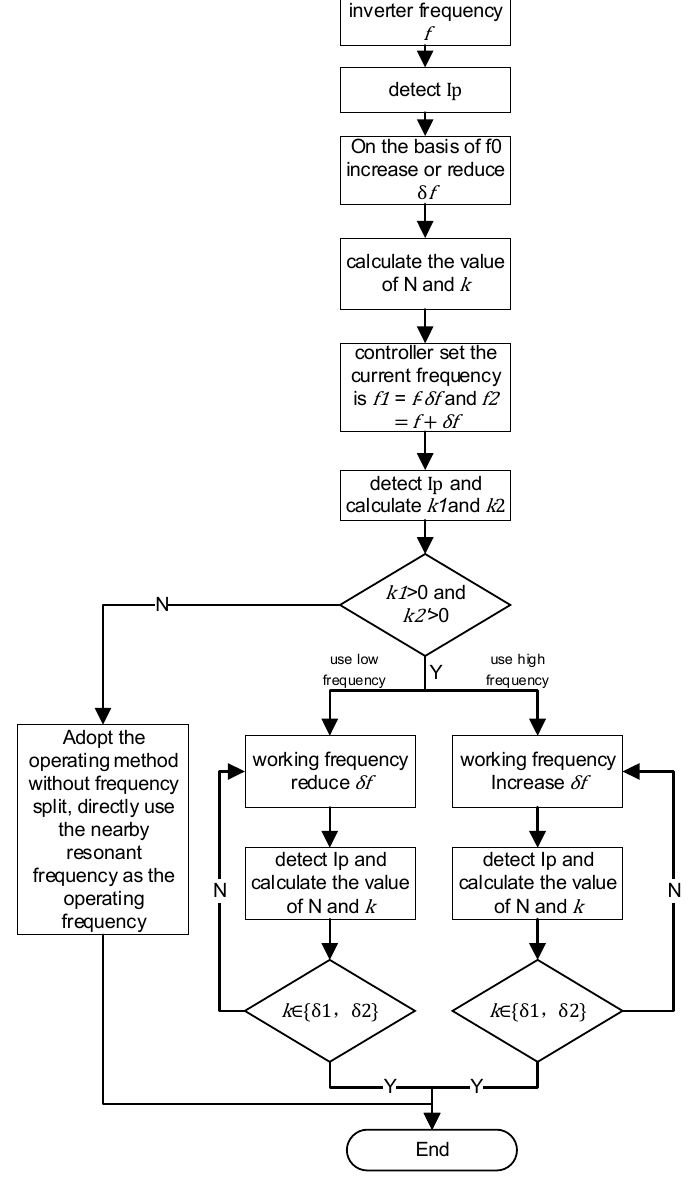
Figure 9. Resonance frequency adjustment control flow chart considering the frequency bifurcation.